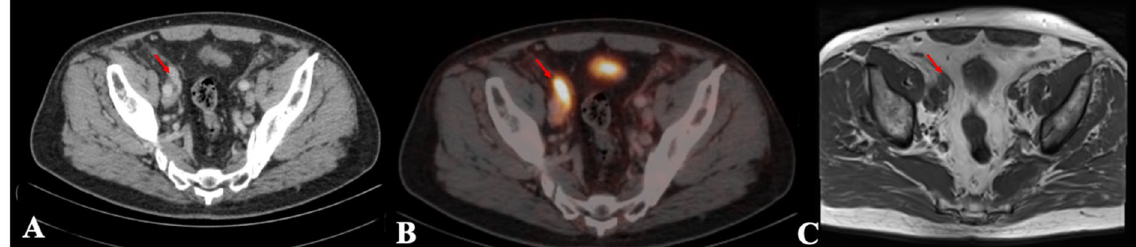
Figure 7. Example of a lymph node larger than 10 mm in 68 Gallium-Prostate specific membrane antigen PET-CT compared to T1 MRI. This figure shows a suspicious lymph node larger than 10 mm diameter. The lymph node is visualized in corresponding axial plane slices using CT, 68 Gallium-Prostate specific membrane antigen PET-CT and T1 MRI from left to right. The lymph node is located at the right external artery. The lymph node is highlighted through red arrows. ( A ) Lymph node depicted in CT, ( B ) Lymph node depicted in 68 Gallium-Prostate specific membrane antigen PET-CT, ( C ) Lymph node depicted in the T1 sequence in